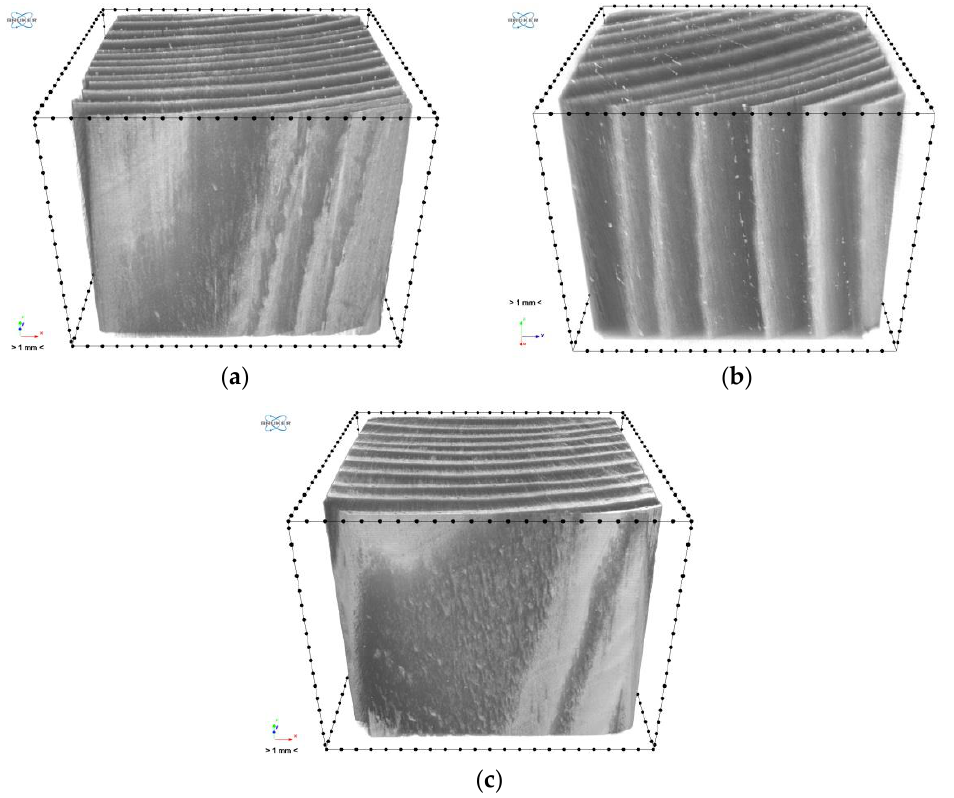
Figure 15. Reconstruction—3D view: ( a ) sample “1”, ( b ) sample “2”, ( c ) sample “3”.